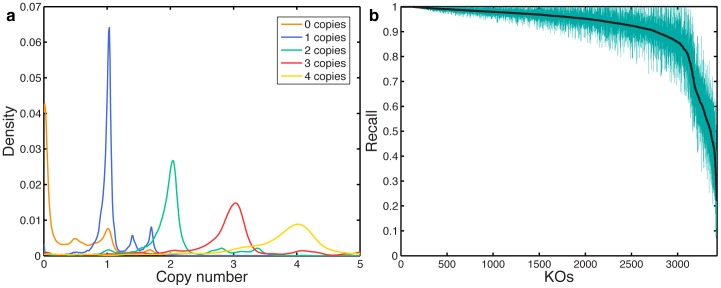
Performance of BLAST-based annotation in recovering the functional profile of a complete set of reads.(a) The probability function of predicting the copy number of a given KO in a given dataset across all simulated 101-bp datasets using the top gene protocol and when the strain from which the reads originated is absent from the database. Only KOs with copy numbers 1 to 4 are illustrated. The curve corresponding to copy number 0 represents false positive KO predictions. The smaller peaks showing in some curves (e.g., the two extra peaks in the blue “1 copy” curve) were found to be due to stretches of intergenic reads that mismapped to KO genes in the database and likely reflect genomic misannotations or pseudogenes. (b) The average recall across all simulated 101-bp datasets for identifying reads originating from each KO, ranked from highest to lowest average recall. 95% confidence intervals are shown in green. Recall is calculated for the case where the strain from which the read originated is absent from the database.